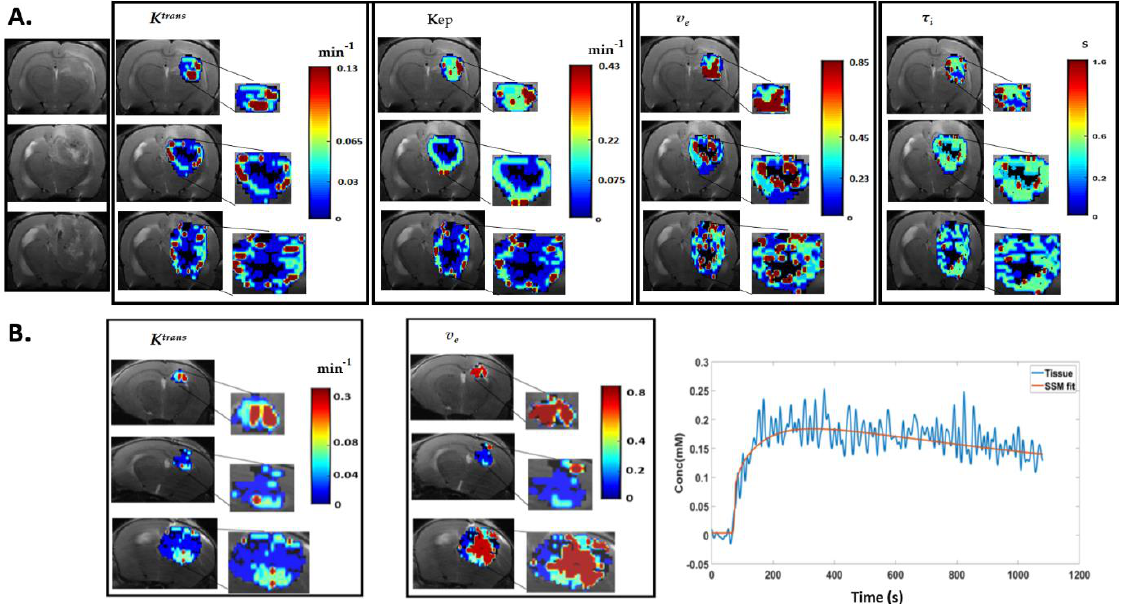
Figure 1. ( A ) Assessing tumour haemodynamic heterogeneity with DCE-MRI using the SSM model. T2 weighted images from a control animal bearing F98 tumour at T0 (top row), T6 (middle row), and T8 (bottom row). The colour coded parametric maps of K trans , K ep, v e , τ i and segmented into clusters using hierarchical clustering algorithm are displayed as overlays on the T2 weighted images in the respective columns, and the zoomed area of the tumour are shown. The poor fit necrotic clusters (black), low (blue), medium (green), and high value clusters (red) are shown, and the mean values of the parameters in the respective clusters are explained in the colour bars. ( B ) Clustered K trans and v e map using SSM overlaid on T2 weighted images from time points T0 , T6 , and T10 from a GL261 mouse GBM and an example of a GL261 tumour tissue Gd-DTPA kinetics and corresponding model fitting using